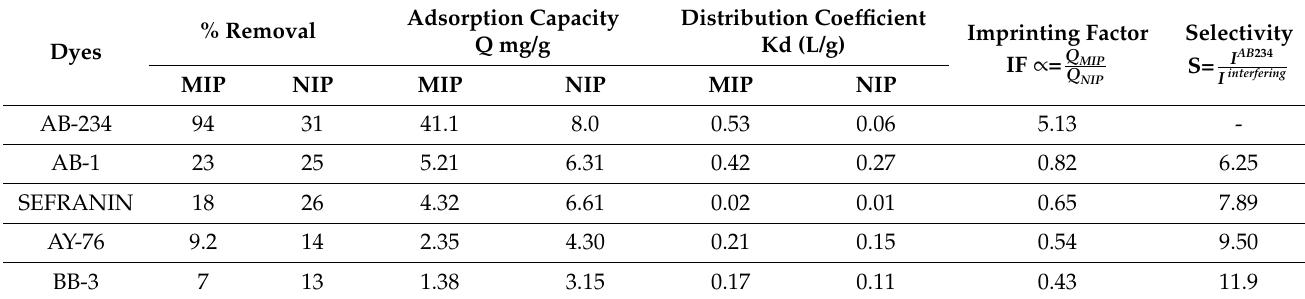
Table 5. Adsorption parameters for dyes (MIP/NIP).